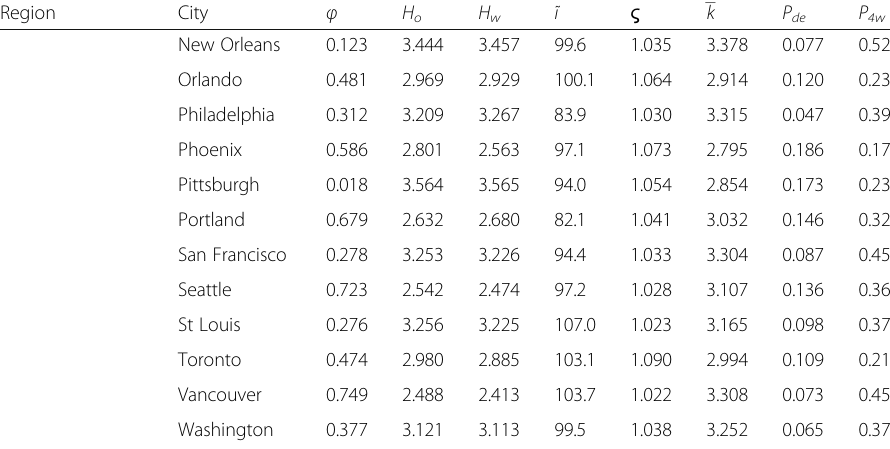
Table 1 Resulting indicators for the 100 study sites (Continued) Region